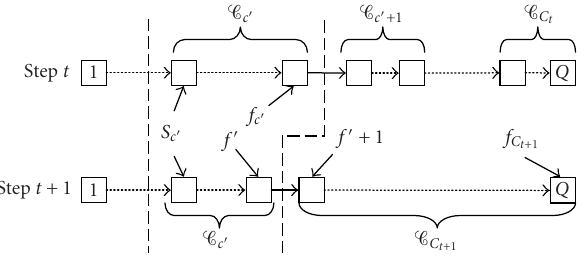
Figure 7: Case 1 of the COP allocation algorithm. At step t , L (cid:5) c exceeds NS and hence is truncated. Its trailing elements and the rest of source elements are allocated to one COP, (cid:5) C t